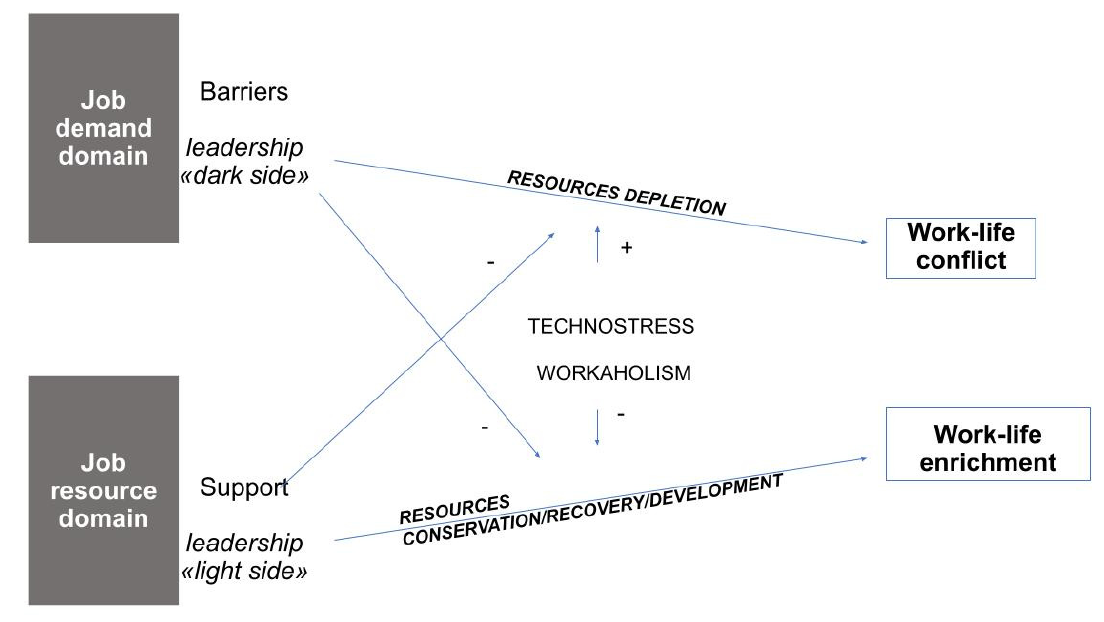
Figure 1. The conceptual model.